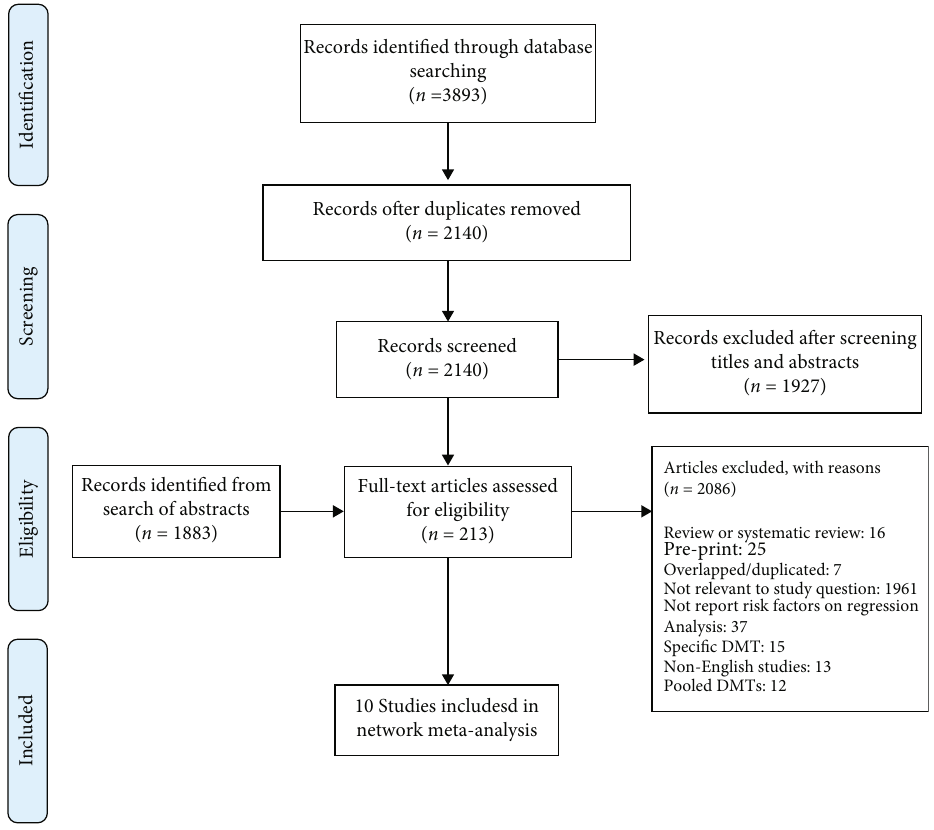
Figure 1: Study fl ow